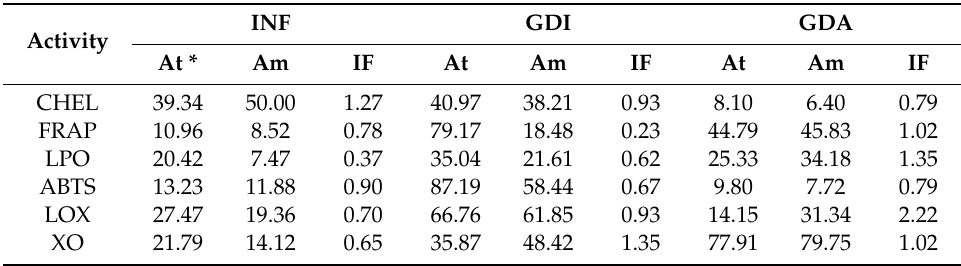
Table 2. Comparison of theoretical activity (At), measured activity (Am)and interaction factors (IF) of extracts from leaves and root of S.